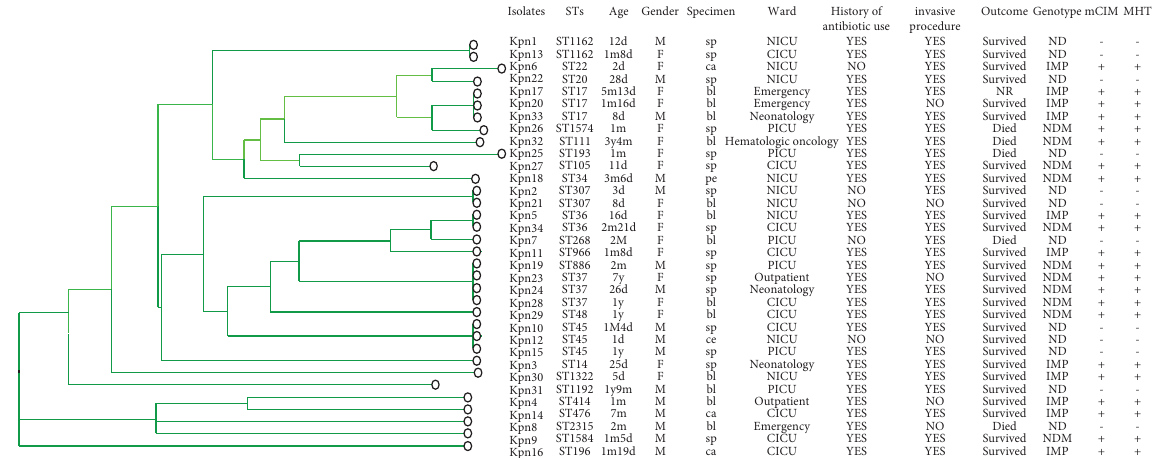
Figure 2: Dendrogram of MLSTdata from the K. pneumoniae isolates. Te UPGMA algorithm was performed to construct a dendrogram based on the dice similarity coefcient. KPN, K. pneumoniae ; d, day; m, month; y, year; M, male; F, female; sp, sputum; ca, catheter; bl, blood; pe, pleural efusion; PICU, pediatric intensive care unit; NICU, neonatal intensive care unit; CICU, cardiac intensive care